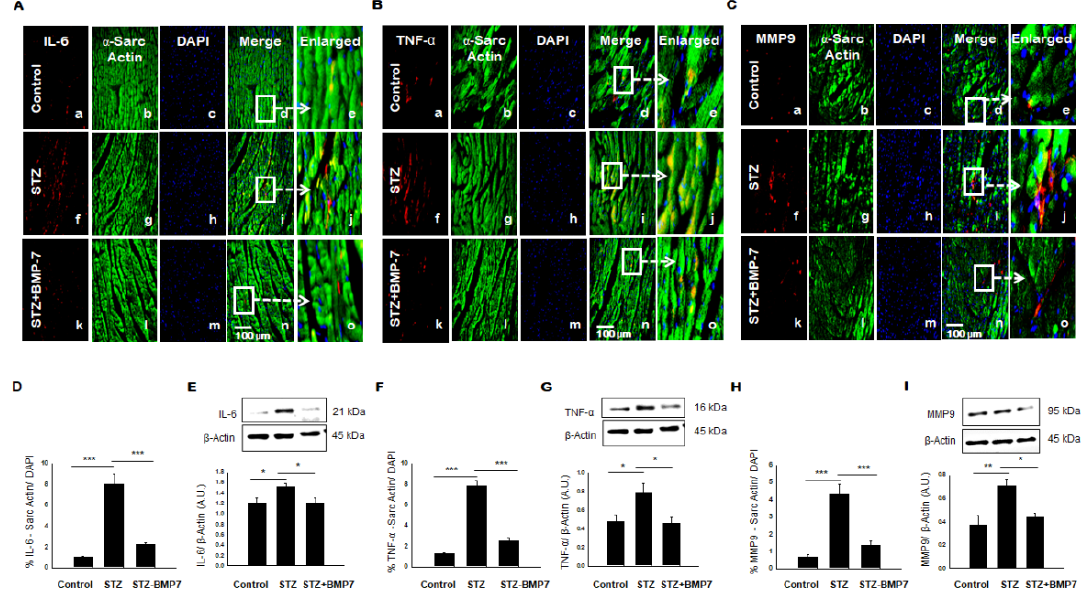
Figure 4. BMP-7 decreases the expression of inflammatory cytokines IL-6 and TNF- α , and proteolytic MMP9 in the diabetic heart. ( A – C ) Representative photomicrographs of heart sections stained in the control group (a–e), STZ group (f–j), and STZ-BMP7 group (k–o) with sarcomeric- α actin (green, stained cardiac myocyte) (b, g, l) and inflammatory markers IL-6 ( A ), TNF- α ( B ), and MMP9 ( C ) in red (a, f, k) with nuclei stained (c, h, m) by DAPI in blue, merged (d, i, n) and enlarged (e, j, o) image. ( D , F , H ) Quantitative analysis-derived histograms of IL-6 ( D ), TNF- α ( F ), and MMP9 ( H ) +ve cardiomyocytes (colocalization of both red and blue DAPI in green cardiomyocytes) were quantified over total DAPI in heart sections of mice. ( E , G , I ) Representative Western blots and densitometric analysis of IL-6 ( E ), TNF- α ( G ), and MMP9 ( I ) markers are shown. Quantities are presented as an arbitrary unit (A.U). Statistical analysis was performed using One-Way ANOVA, which was followed by the Tukey test. Error bars= mean ± S.E.M. * p < 0.05, ** p < 0.01, *** p < 0.001; Scale bar = 100µm; n = 16/group.